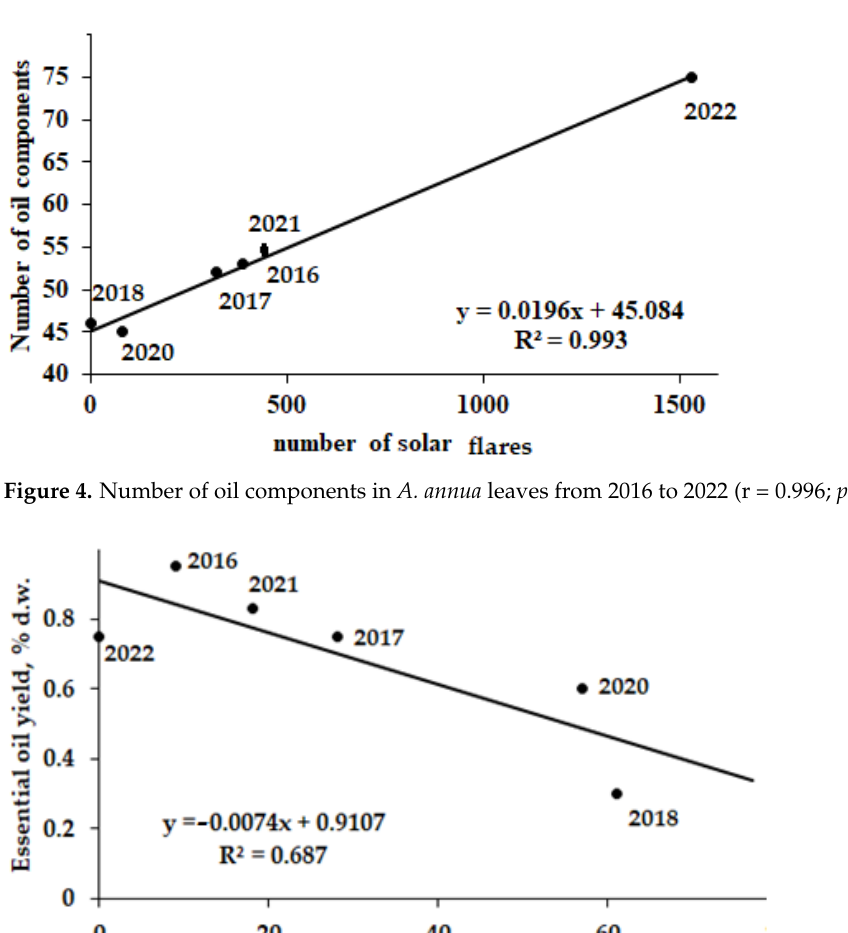
Figure 4. Number of oil components in A. annua leaves from 2016 to 2022 (r = 0.996; p < 0.0001). Figure 5. Accumulation of essential oil in A. annua leaves from 2016 to 2022 (r = − 0.829; p < 0.01).